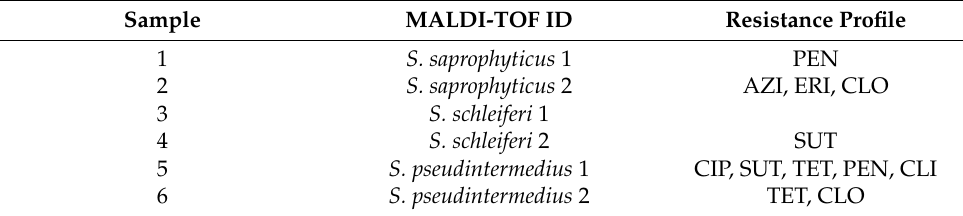
Table 1. Staphylococcus isolates identification and resistance profile by MALDI-TOF mass spectrometry and disk-diffusion assay, respectively.